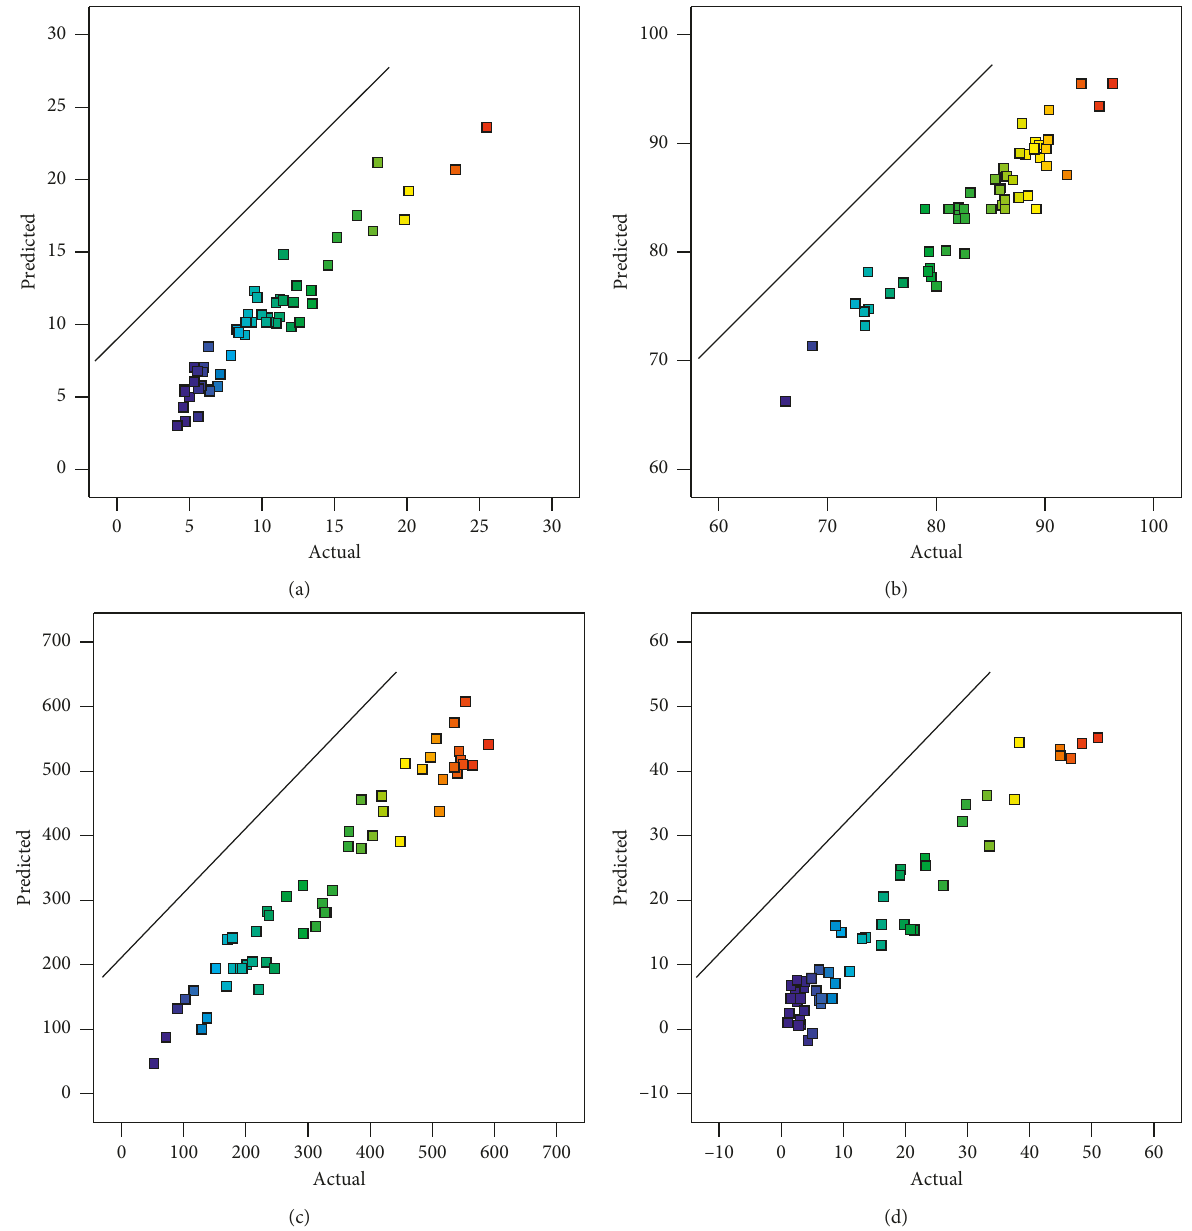
Figure 5: Scatter plot: predicted values of (a) surface roughness, (b) density, (c) tensile strength, and (d)